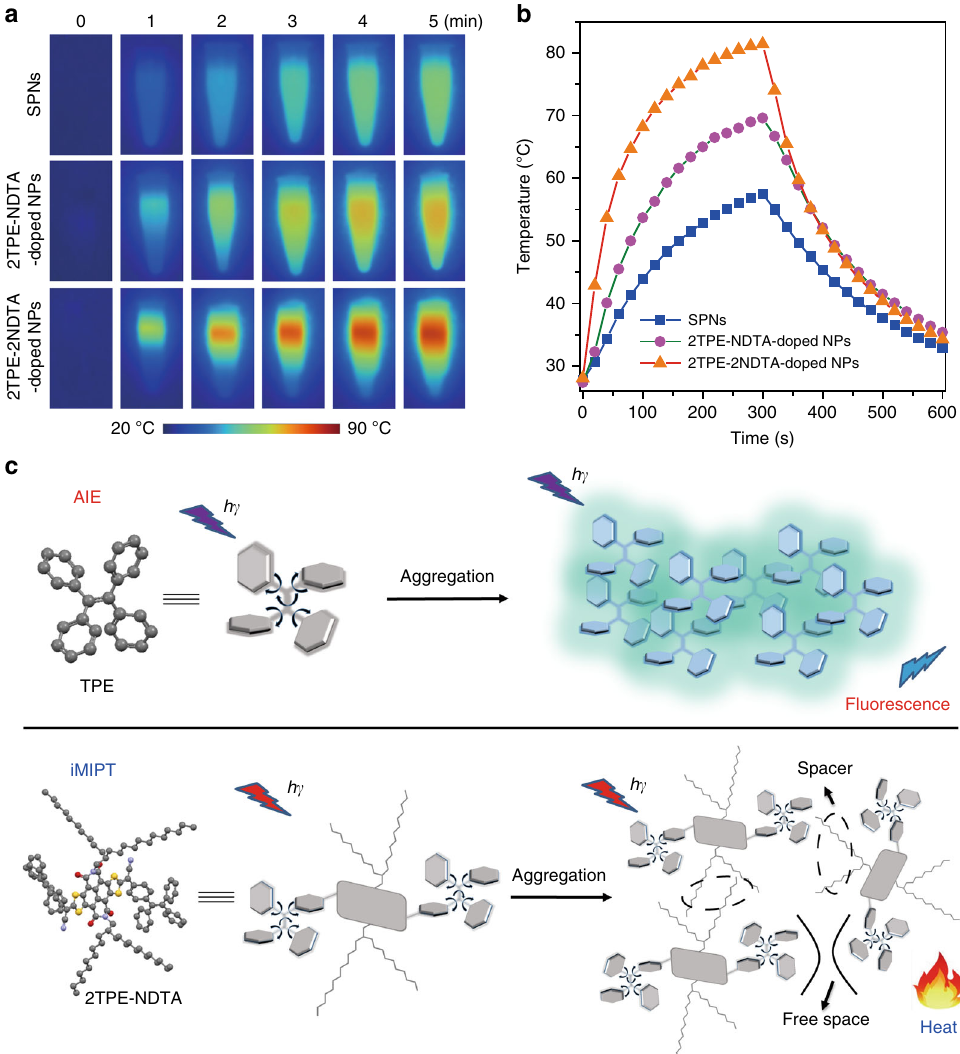
Fig. 4 Photothermal conversion and working mechanism of iMIPT NPs. a IR thermal images of various NPs in aqueous solution (100 μ M based on 2TPE- 2NDTA, 2TPE-NDTA and the repeat unit of semiconducting polymer) upon exposure to 808 nm (0.8 W cm − 2 ) laser irradiation for different times. b The temperature changes of solutions of various NPs as a function of time. The solutions were irradiated with 808 nm laser (0.8 W cm − 2 ) for 300 s followed by naturally cooling for another 300 s. c The sketch map of working mechanisms of AIE and